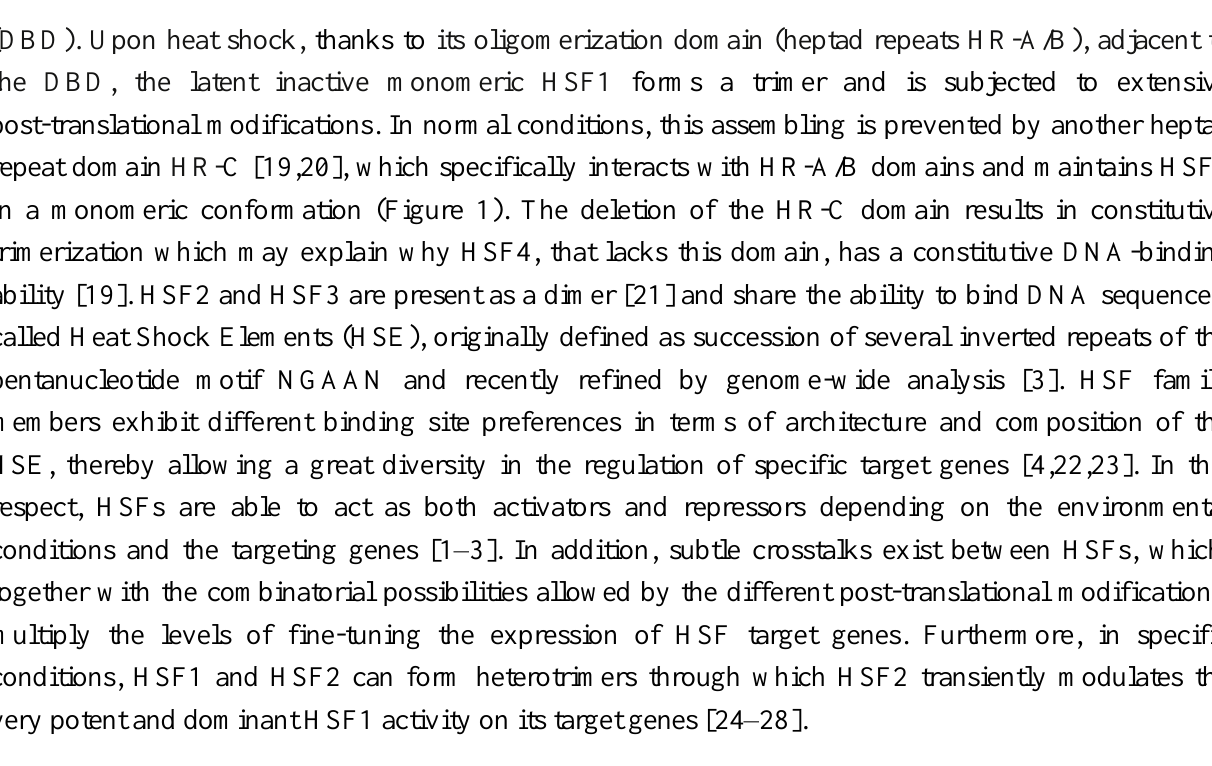
Figure 1. Structure of Heat Shock Factors